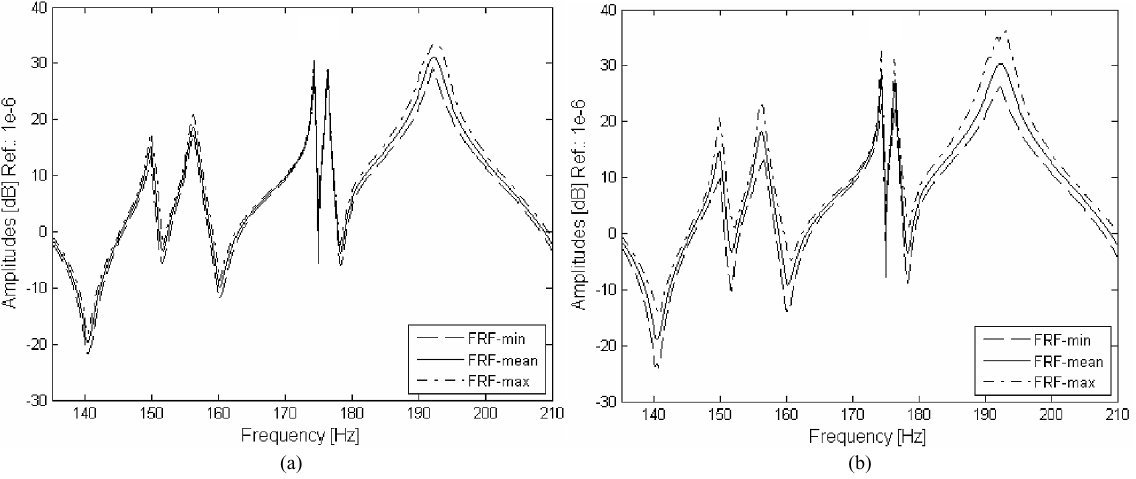
Fig. 8. Envelopes of random FRFs of the damped stiffness panel for uncertainty levels: (a) Case 1, (b) Case